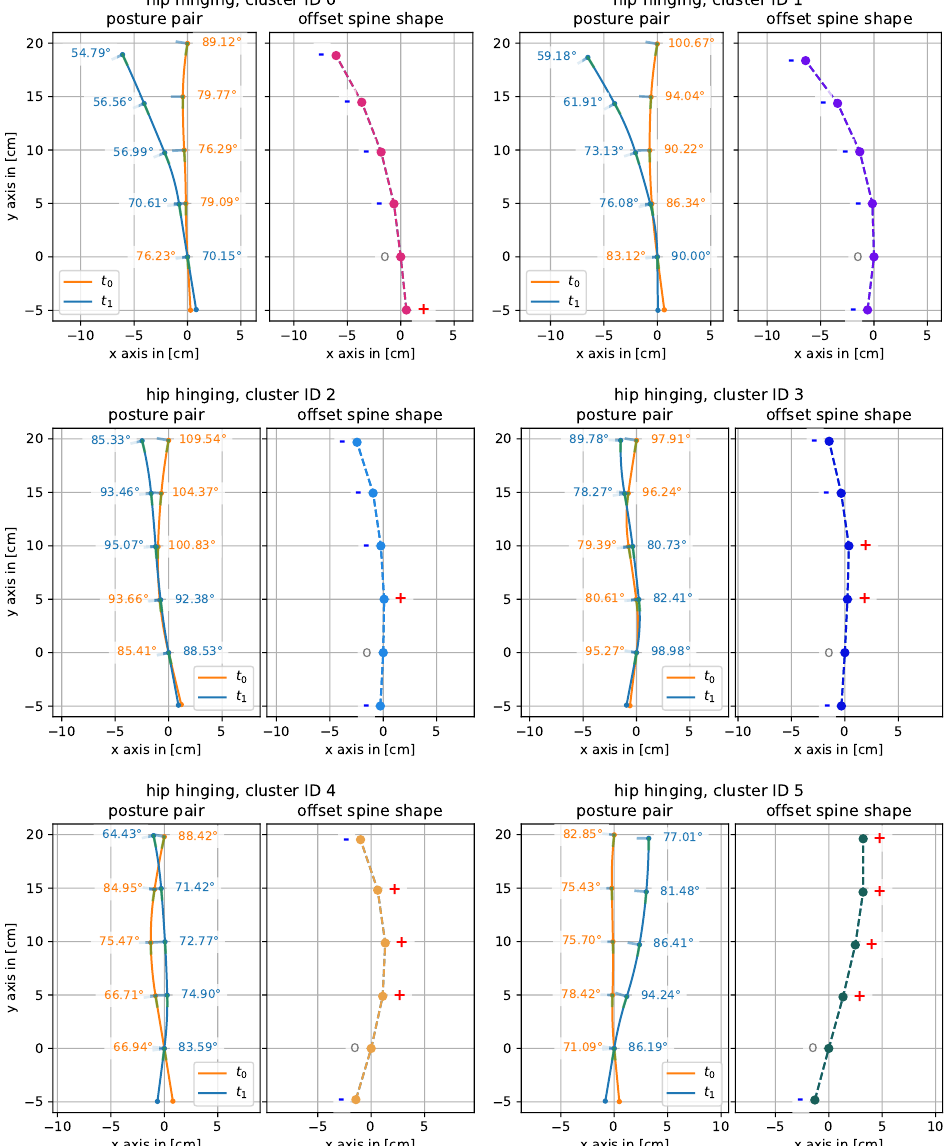
Figure A6. Results for clustering posture pairs of hip hinging . Cluster representative sample posture pairs and offset spine shapes for each cluster. Each sample’s position within its cluster is marked by an ‘x’ in the colored t-SNE map. The two posture snapshots are additionally rotated about the origin such that the topmost sensor of the unguided t 0 snapshot lies on the y